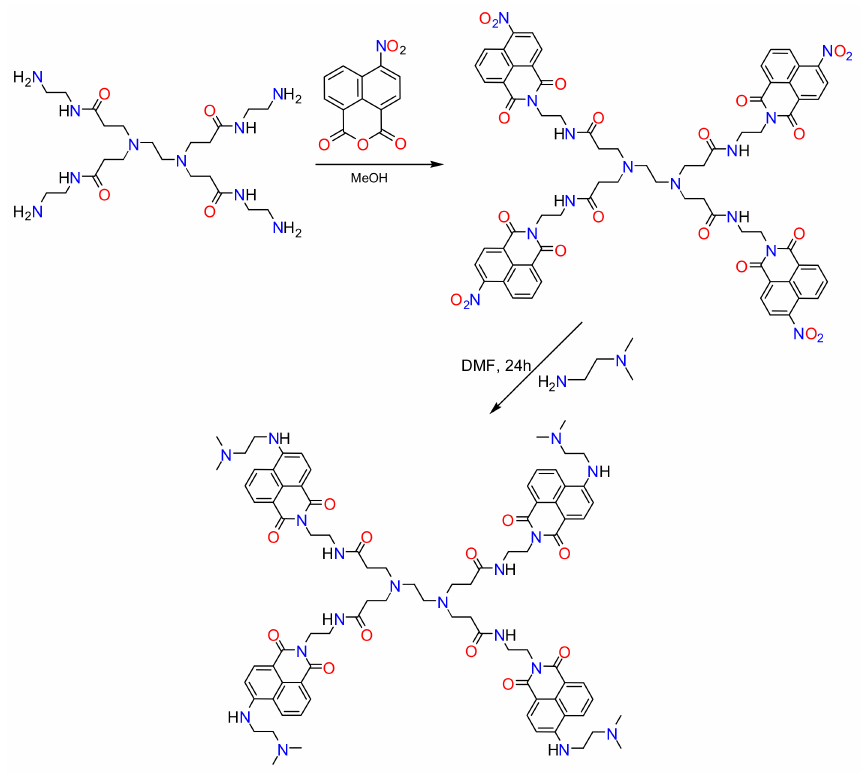
Figure 2. Synthetic route to the FCD